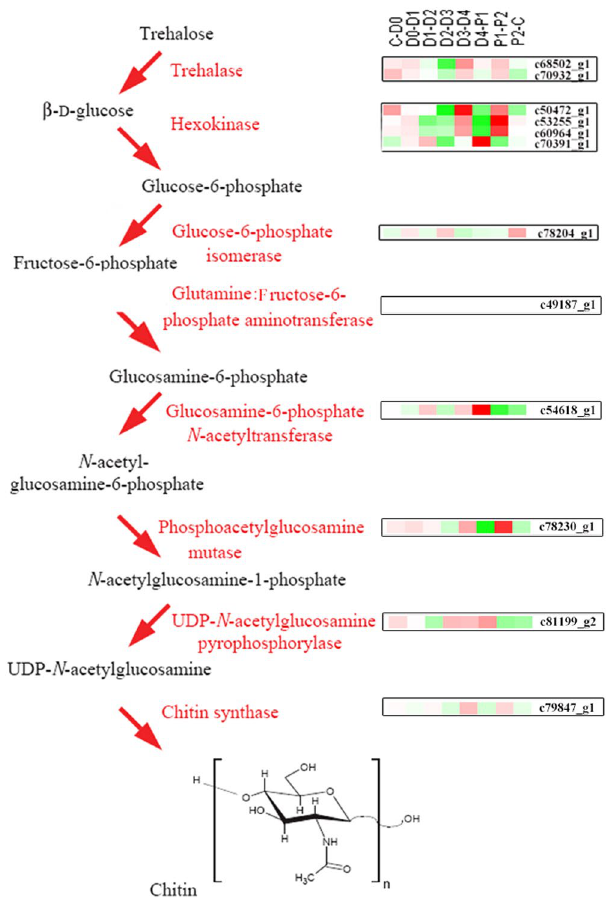
Figure 7. Expression profile of chitin synthesis pathways using the insect analogy. It displays expression patterns for all chitin synthesis factors in each comparison. The colour key represents FPKM normalized log 2 transformed counts. Red represents up-regulated expression and green represents down-egulated expression. The diagrammatic representation is based on previous studies in insects 57